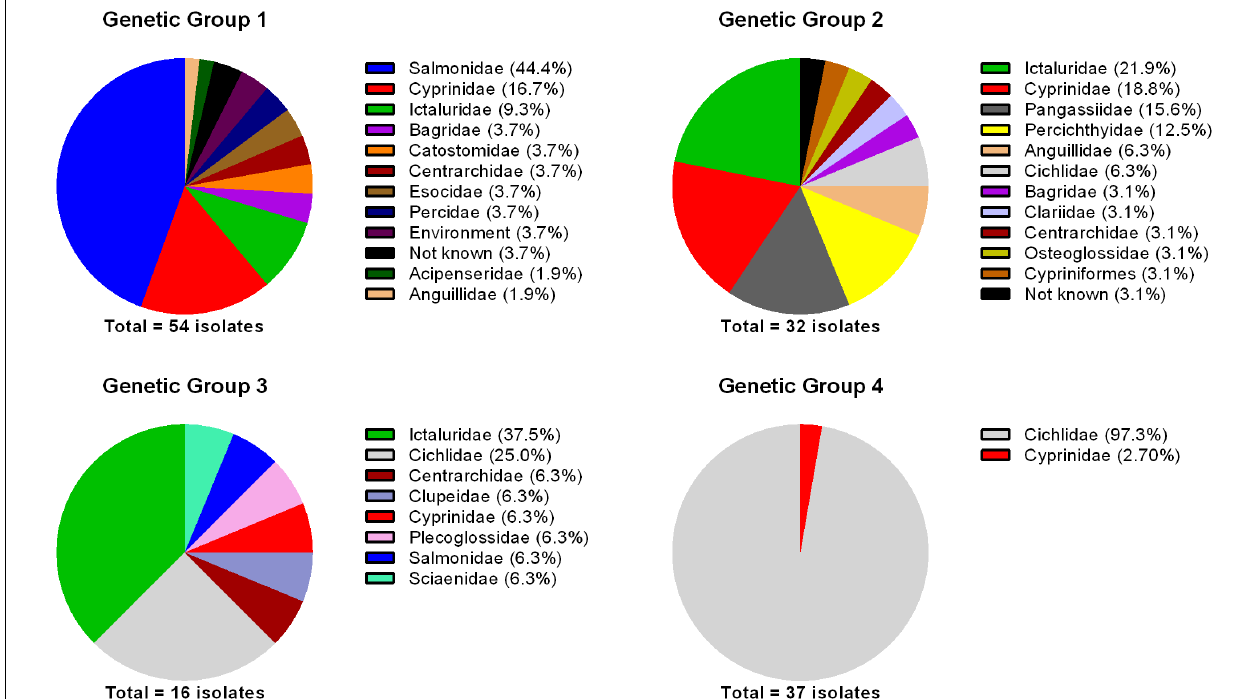
FIGURE 4 | Percentage of Flavobacterium columnare isolates in each genetic group recovered from fish species in the families indicated. The number of isolates included in the analysis is indicated below the pie